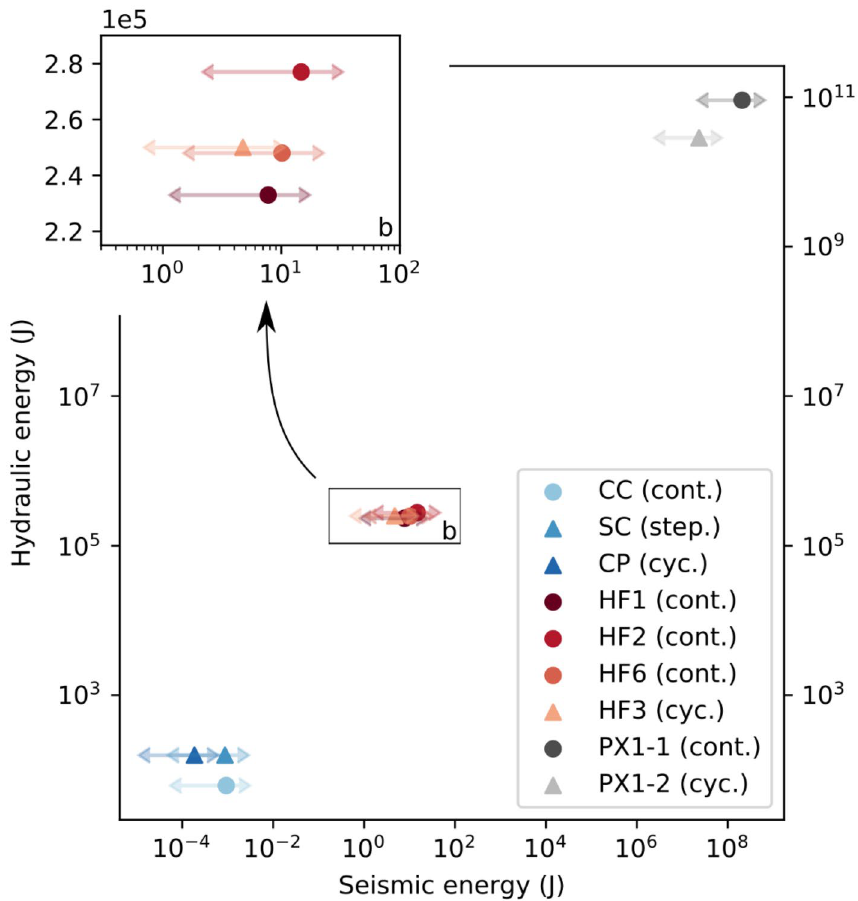
Figure 7. Hydraulic versus radiated seismic energy across